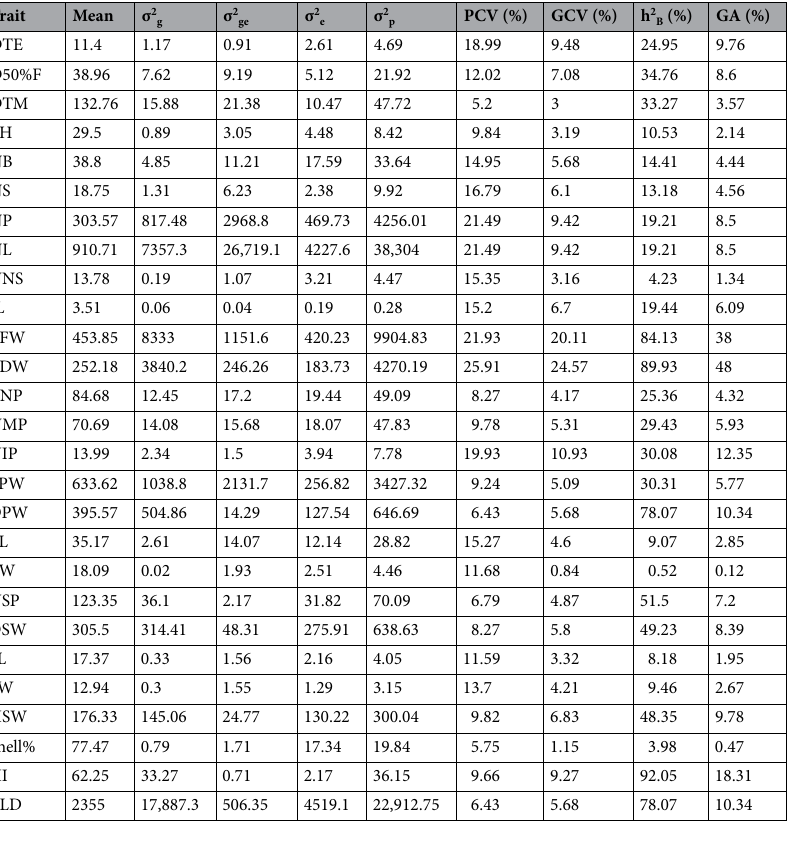
Table 9. Estimation of variance component, heritability, and genetic advance for 27 phenotypic traits in 30 Bambara groundnut accessions. σ 2 g genotypic variance, σ 2 ge genotype by environment variance, σ 2 e error variance, σ 2 p phenotypic variance, PCV Phenotypic coefficients of variation, GCV Genotypic coefficients of variation, h 2 B heritability, and GA genetic advance; DTE Days to emergence (d), D50%F Days to 50% flowering (d), DTM Days to maturity (d), PH Plant height (cm), NB Number of branches per plant, NS Number of stems per plant, NP Number of petioles per plant, NL Number of leaves per plant, NNS No. of nodes per stem, IL Inter nodes length (cm), BFW Biomass fresh weight per plant (g), BDW Biomass dry weight per plant (g), TNP Total no. of pods per plant, NMP Number of mature pods per plant, NIP Number of Immature pods per plant, FPW Fresh pods weight (g), DPW Dry pods weight (g), PL Pod length (mm), PW Pod width (mm), NSP Number of seeds per plant, DSW Dry seed weight per Plant (g), SL Seed length (mm), SW Seed width